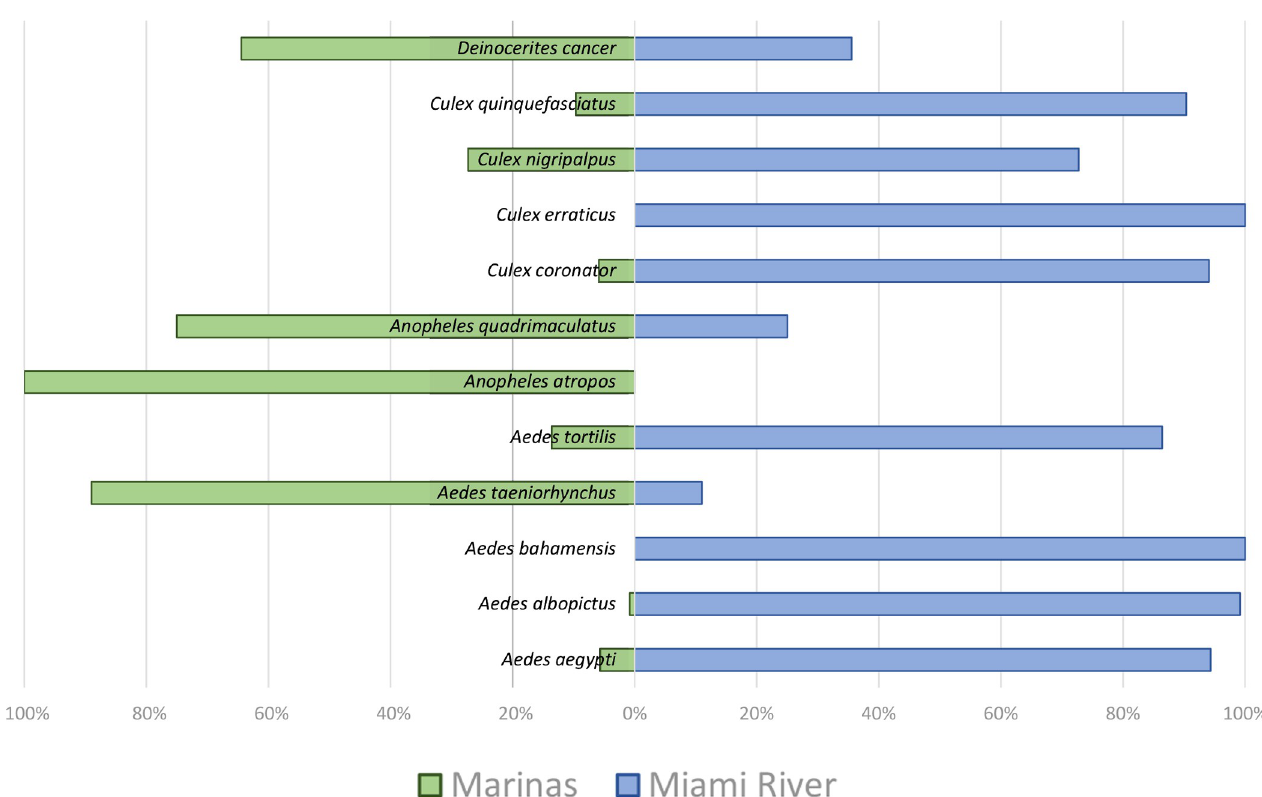
Fig 2. Relative proportion of mosquitoes collected in the two categories of maritime entry ports in Miami-Dade County, Florida, Marinas and commercial ports at the Miami River.